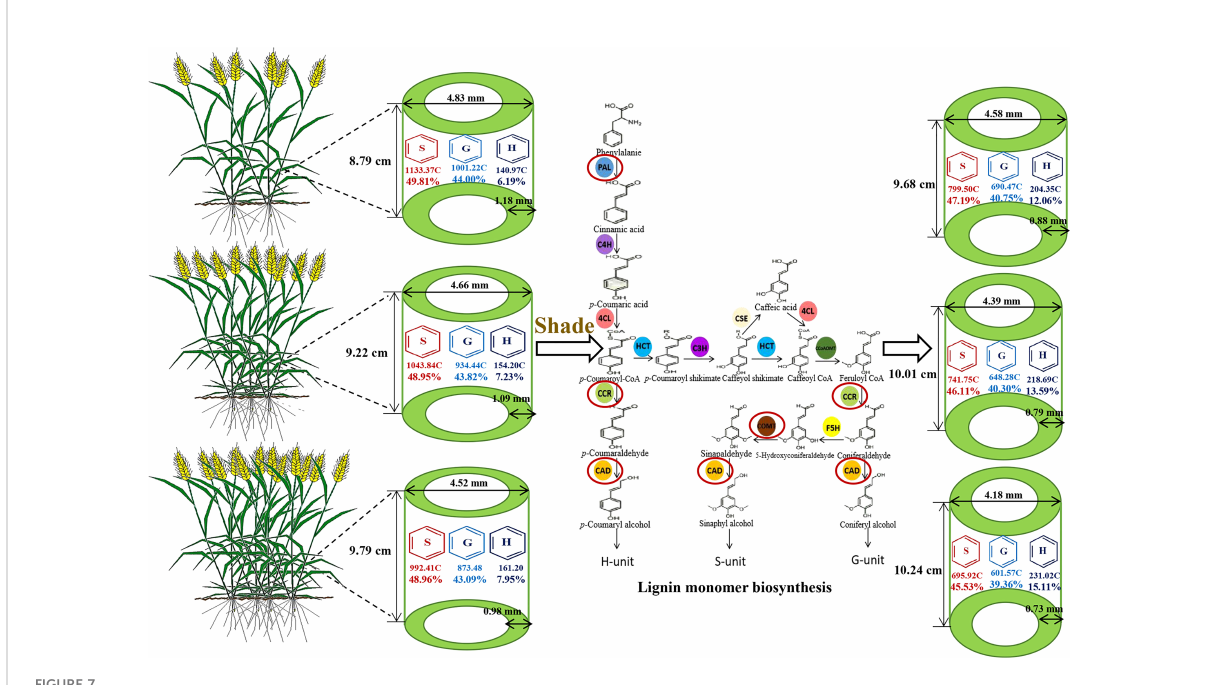
FIGURE 7 Pattern graph of shading affecting stem morphological characteristics and lignin metabolism of wheat under different planting densities. S, syringyl; G, guaiacyl; H, p -hydroxyphenyl; C, concentration unit ( m g g -1 ). PAL, phenylalanine ammonia-lyase; C4H, cinnamate 4-hydroxylase; 4CL, 4-hydroxycinnamate:CoA ligase; HCT, p -hydroxycinnamoyl-CoA shikimate/quinate hydroxycinnamoyl transferase; C3H, coumarate 3- hydroxylase; CSE, caffeoyl shikimate esterase; CCoAOMT, caffeoyl CoA o-methyl transferase; F5H, ferulate/coniferaldehyde 5-hydroxylase; CCR, cinnamoyl CoA reductase; CAD, cinnamyl alcohol